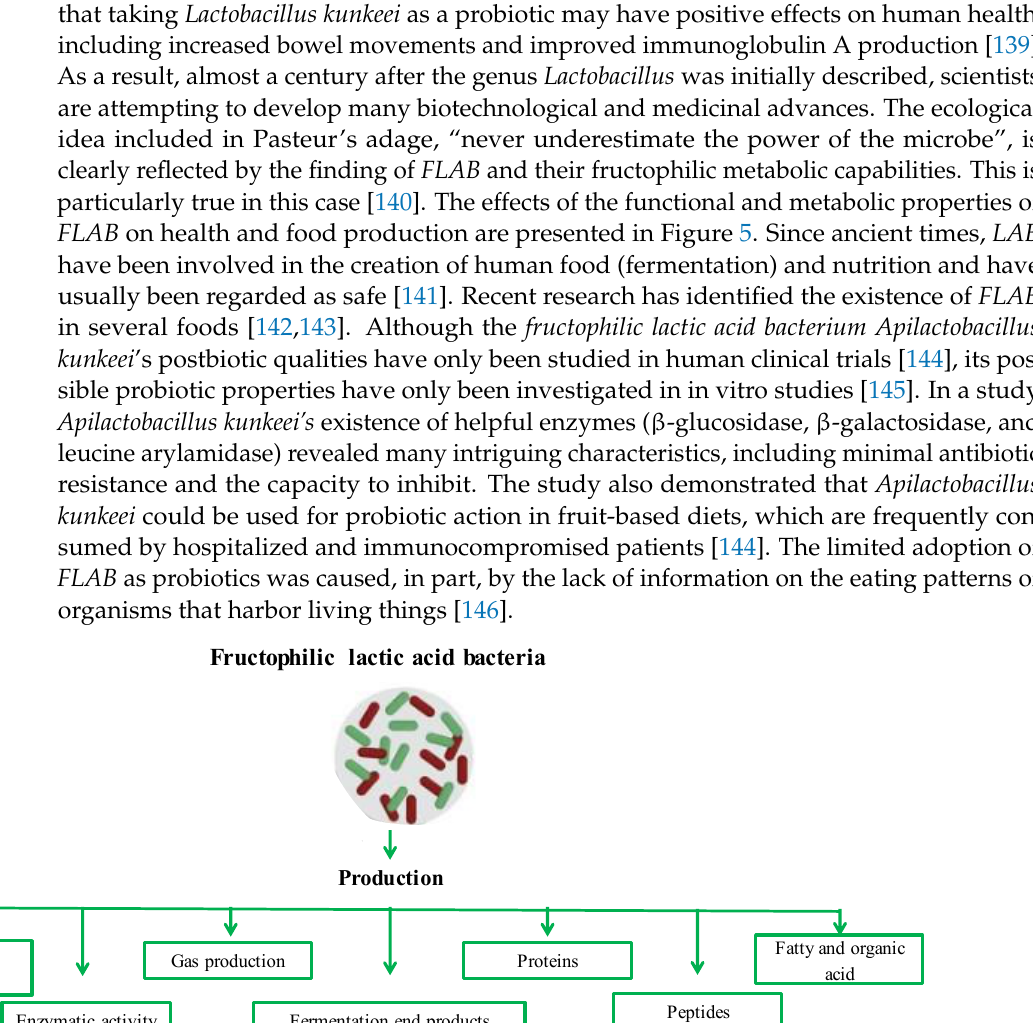
Figure 5. The effects of functional and metabolic properties of FLAB on health and food production .